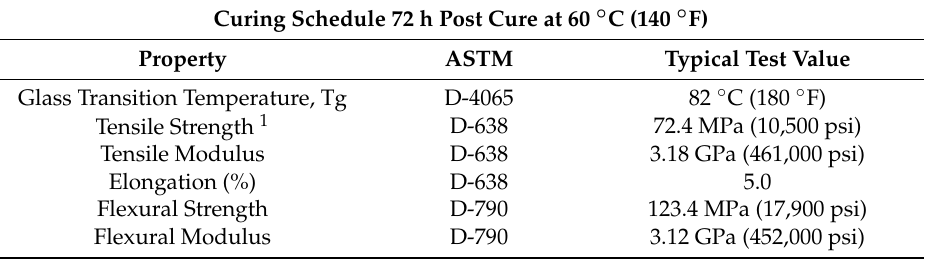
Table 1. Epoxy mechanical properties (from the manufacturer’s